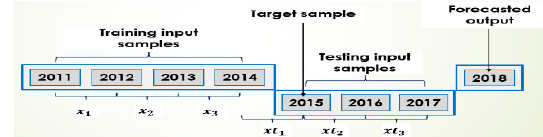
Figure 6. Architecture of the proposed long-term wind forecasting.